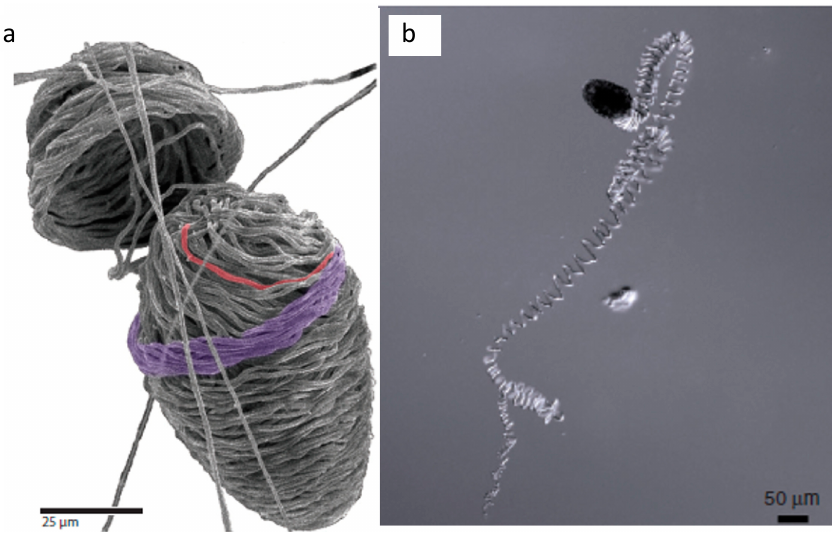
Figure 2. Skein structure and unravelling. ( a ) Scanning electron micrographs of a skin cracked open to reveal the internal organization of staggered thread loops [25]; ( b ) differential interference contrast micrograph of a partially untraveled thread skein [25].